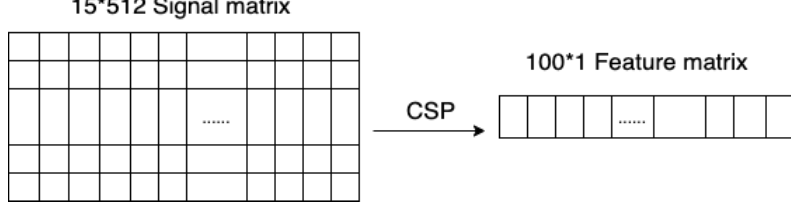
Figure 6. CSP feature